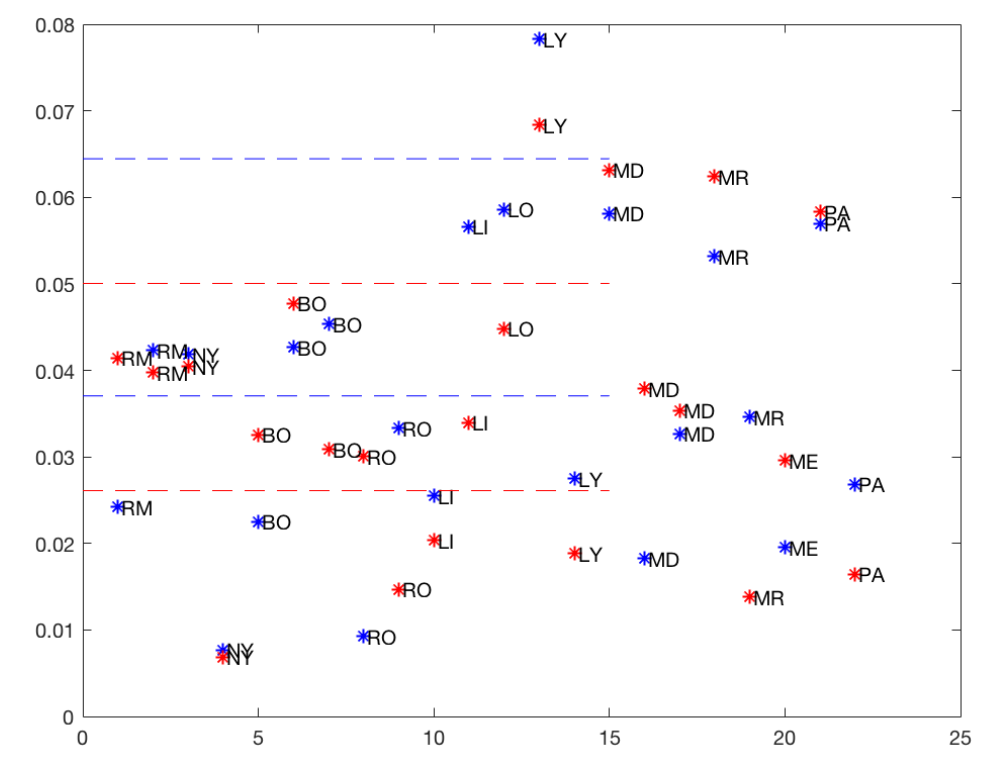
Figure 8. Downward slope: blue: total , red: 50 %. Table 8. Cluster analysis for drops at total and